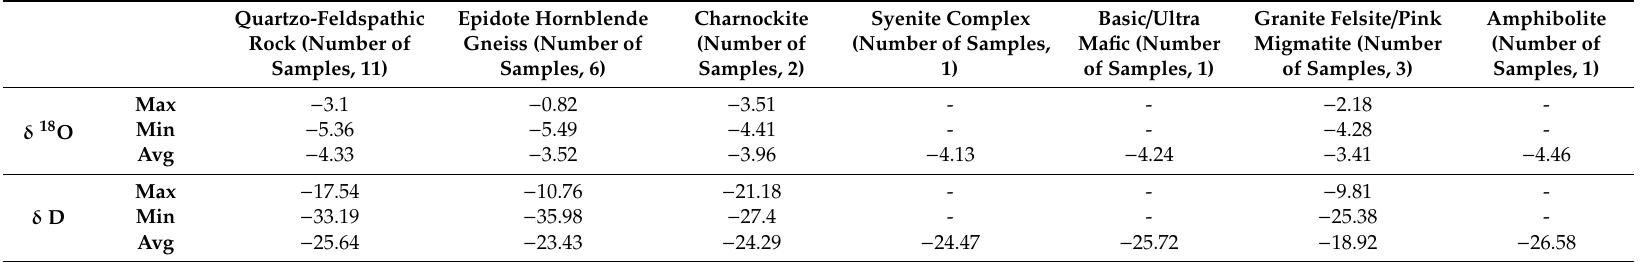
Table 2. Maximum, Minimum and Average values of δ 18 O and δ D for di ff erent lithological unit (All values are in % (cid:24) ). Quartzo-Feldspathic Rock (Number